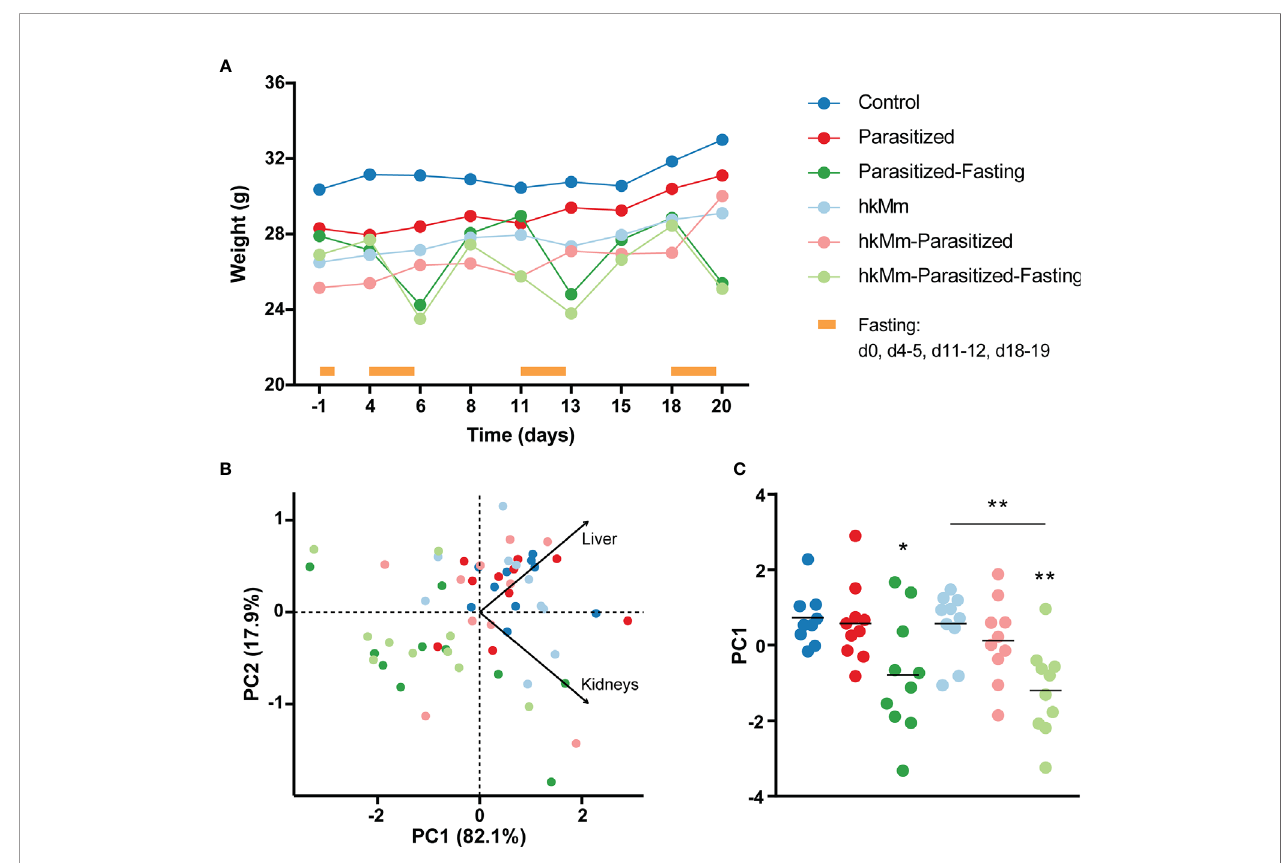
FIGURE 2 | Change of animals ’ body condition. (A) Median weight of mice as infection progresses, infection day being time 0. (B) PCA based on liver and kidneys weight at end-point time. (C) PC1 scores, each circle represents an animal and lines are means; ANOVA p -value=0.0004, Holm-Sidak ’ s multiple comparisons test (*p < 0.05, **p < 0.01). hkMm, heat-killed M. manresensis